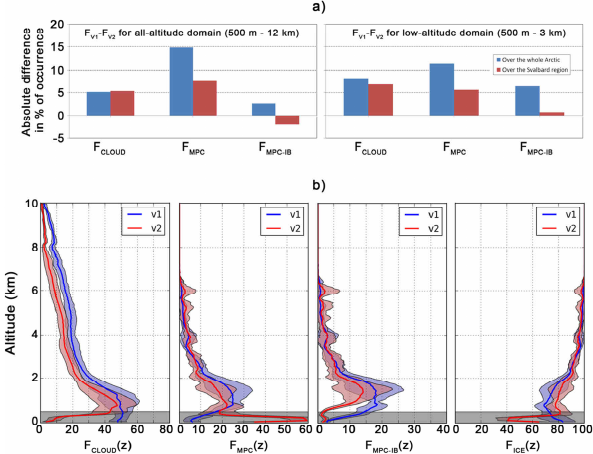
Figure 4. (a) Absolute differences in % of occurrence between oc- currences computed from V1 and V2 DARDAR products for total Figure 4. a) Absolute differences in % of occurrence between occurrences computed from V1 and 3 cloud, MPC and MPC-IB and (b) mean vertical profiles of cloud, V2 DARDAR products for total cloud, MPC and MPC-IB and b) Mean vertical profiles of clouds, 4 MPC, MPC-IB and ice cloud occurrences computed from V1 (blue MPC, MPC-IB and ice clouds occurrences computed from V1 (blue lines) and V2 (red lines) 5 lines) and V2 (red lines) DARDAR products for April 2007 over the DARDAR products for April 2007 over the Svalbard region. Filled areas represent the standard 6 Svalbard region. The filled areas represent the standard deviation. 7